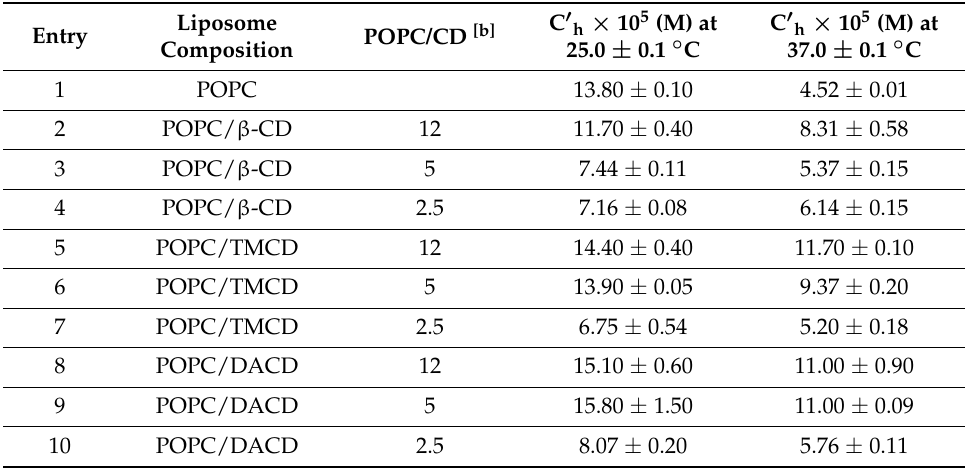
Table 2. Bilayer viscosity (C (cid:48) h ) [a] in pure and CD-doped POPC